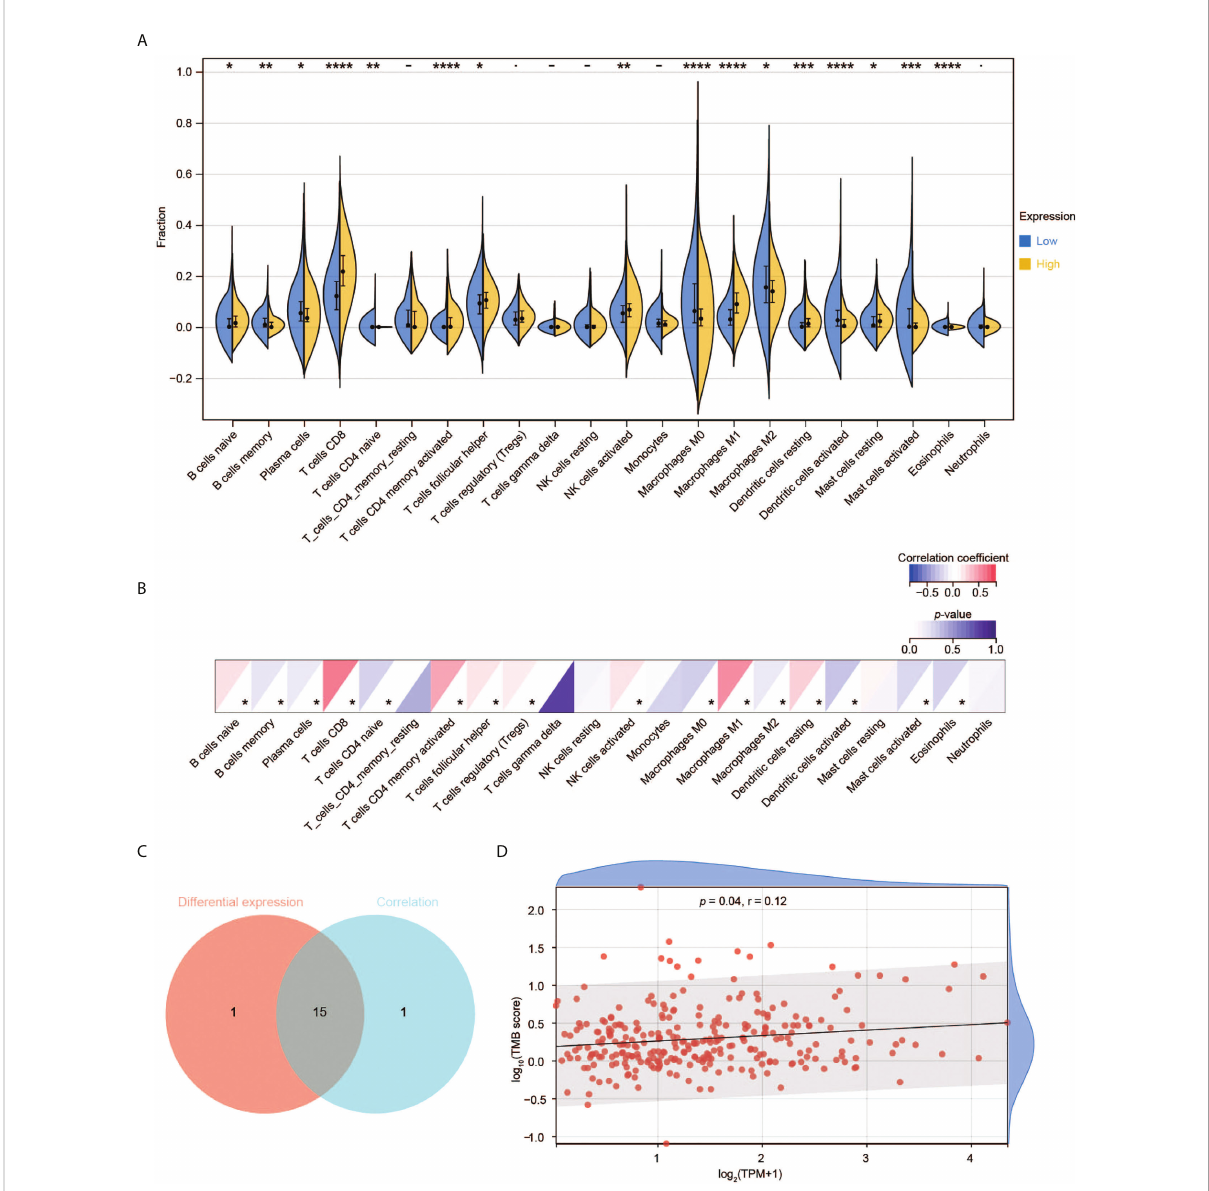
FIGURE 7 Immune cell in fi ltration analysis of CD3G. (A) The difference of TIC proportions with high or low CD3G expression in CESC. (B) The correlation of the TICs and CD3G expression. * p < 0.05, ** p < 0.01, *** p < 0.001, **** p < 0.0001. (C) The shared TICs between the analyses in (A, B) . (D) The correlation of TMB and CD3G